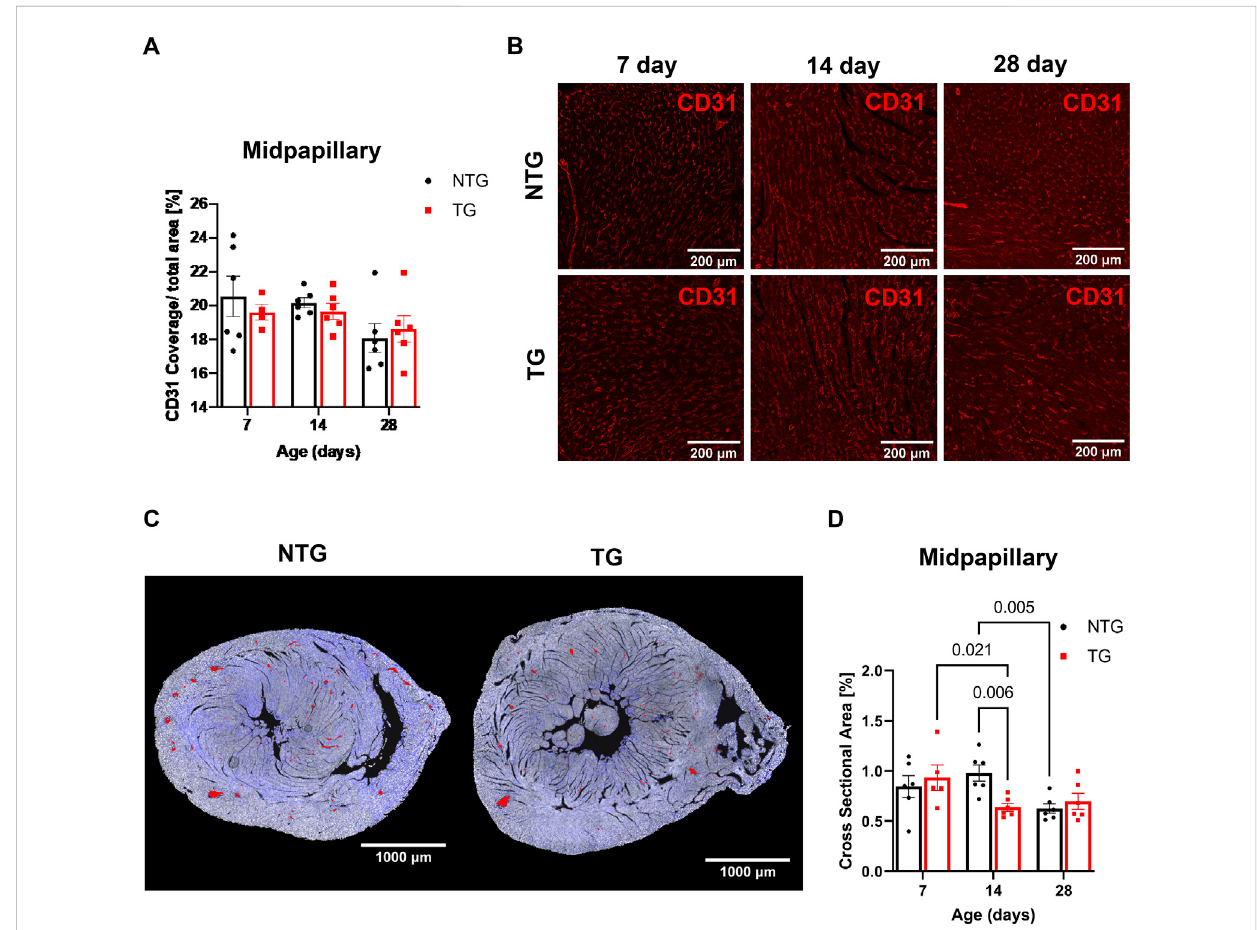
FIGURE 7 Microvessel density and arteriolar cross-sectional area at midpapillary section. (A) Quantitation of CD31 coverage in NTG and TG hearts. (B) Representative images photomicrographs of CD31 labeled (indicating endothelial cells) immuno fl uorescent sections taken at midpapillary levels. (C) Representative photomicrographs of midpapillary sections of whole-heart sections with arterioles are highlighted in red at P14. (D) Quanti fi cation of arteriolar cross-sectional area (%). N = 5 – 6. Data presented as mean ± SEM; Two-way ANOVA followed by Fisher ’ s LSD